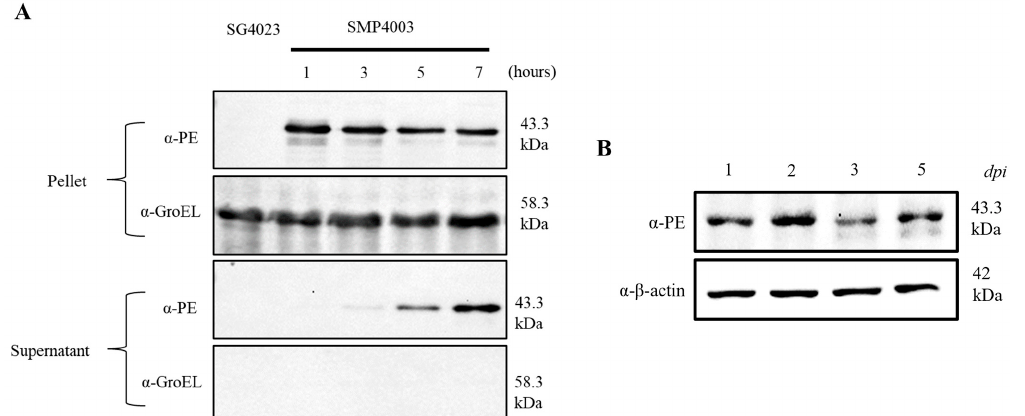
Figure 3. Expression and secretion of TGF α -PE38 (TP) from ∆ ppGpp S. Gallinarum. ( A ) Expression of TP in vitro. ∆ ppGpp S. Gallinarum carrying prrnBP1-psp-TP (SMP4003) were cultured in LB media, and samples were taken at the indicated time points. Bacterial samples were centrifuged to divide into supernatant and pellets. The pellets were sonicated. Aliquots containing 20 ng total protein were loaded onto 10% SDS-PAGE gels to detect TP (43.3 kDa) by western blotting using an antibody against Pseudomonas exotoxin A. The efficiency of bacterial lysis in the pellet was determined using GroEL (58.3 kDa) as a cytosolic protein control. The first lane contains SG4023 without the plasmid. Data represent the results of three independent replicates. Uncropped membranes are shown in panels A, B, and C in Figure S7. ( B ) Expression of TP in vivo. The above bacteria were injected into CT26 tumor-bearing mice via the tail vein (1 × 10 8 CFU/mouse). On the indicated days, tumors were excised and homogenized, lysates were centrifuged and filtered, and supernatants were collected. The presence of TP was determined by western blotting. β -actin was used as the loading control (42 kDa). Representative data are the results of two independent replicates. Uncropped membranes are shown in panels D and E in Figure S7.